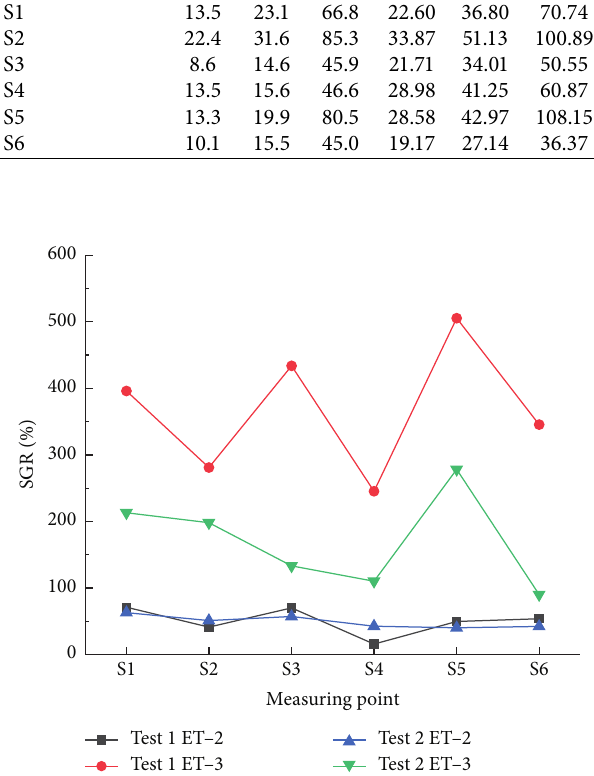
Figure 10: Case 1 strain growth rate of structure.